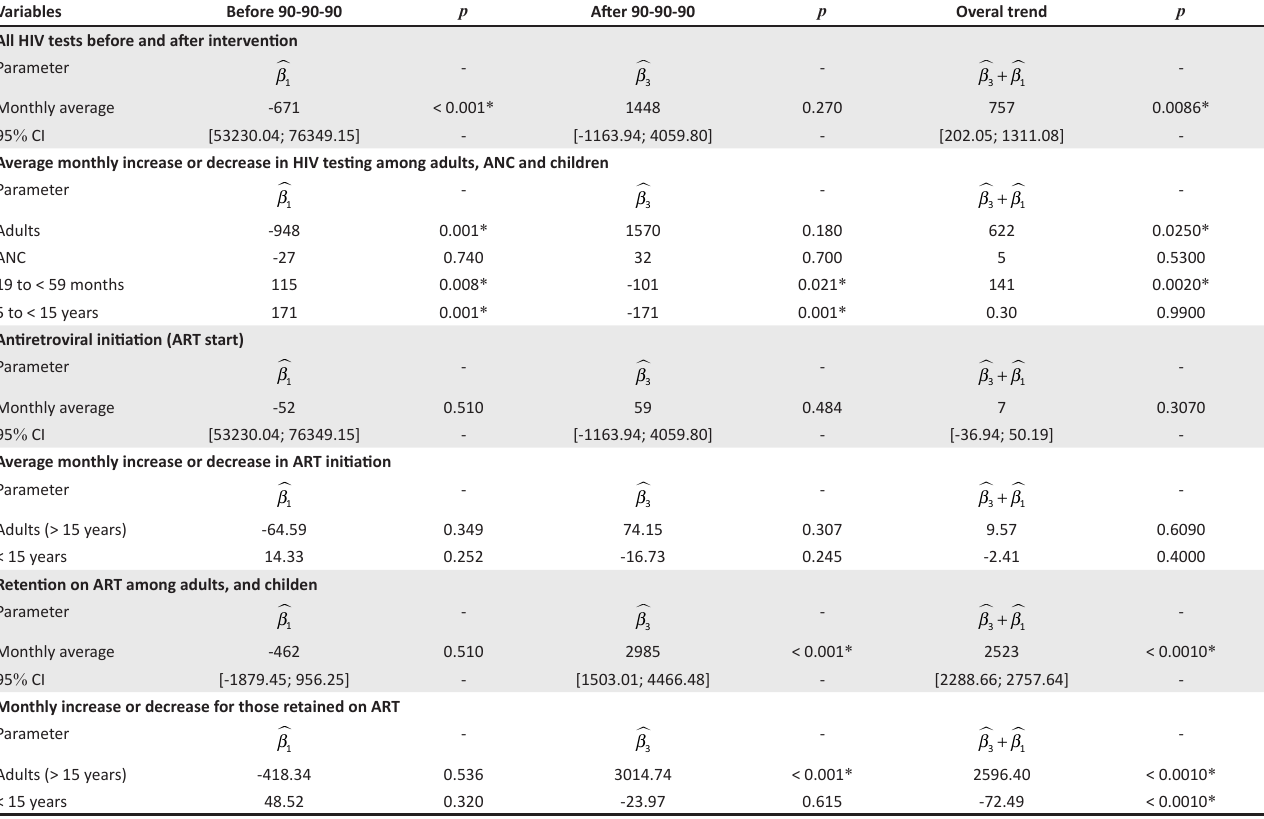
TABLE 2: The monthly average change in HIV testing and ART initiation of youths and adults (> 15yrs) and of children (< 15yrs) before (9 months) and after (38 months) the 90-90-90 implementation or intervention. Variables